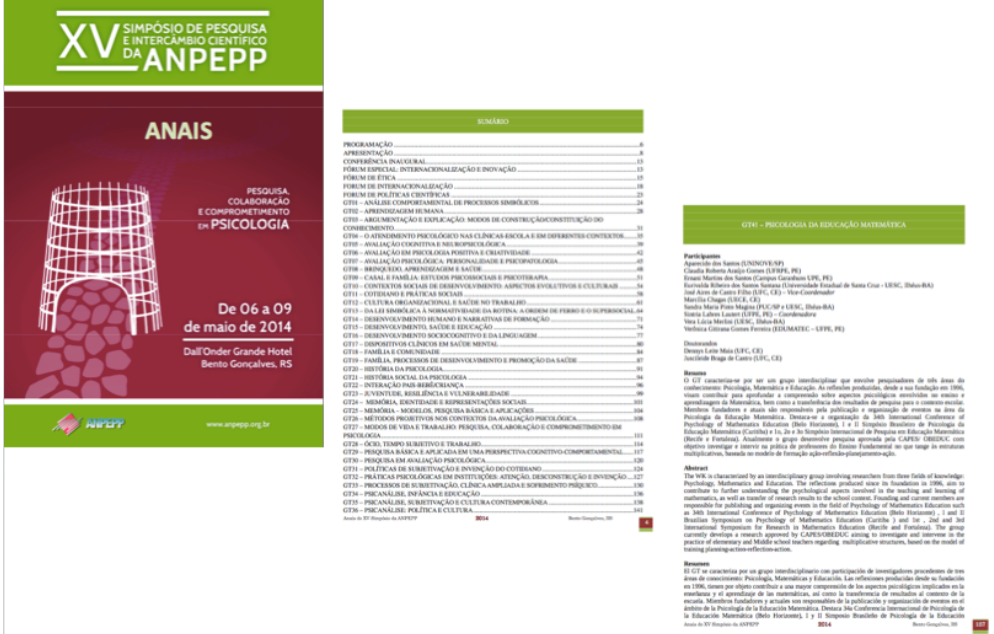
Figure 2 . Cover page, index, and chapter from the proceedings of ANPEPP’s XV